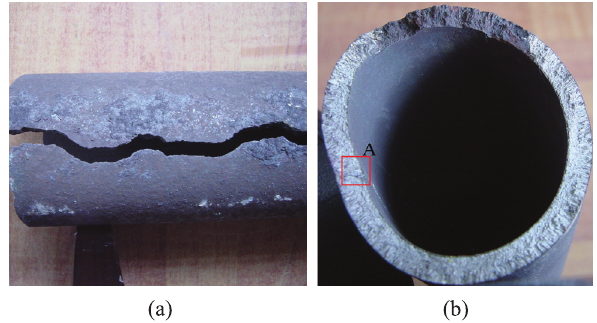
Fig. 1: Cracked ethylene cracking furnace tubeethylene cracking furnace tubeethylene cracking furnace tube caused by carburization: (a) general view; (b)